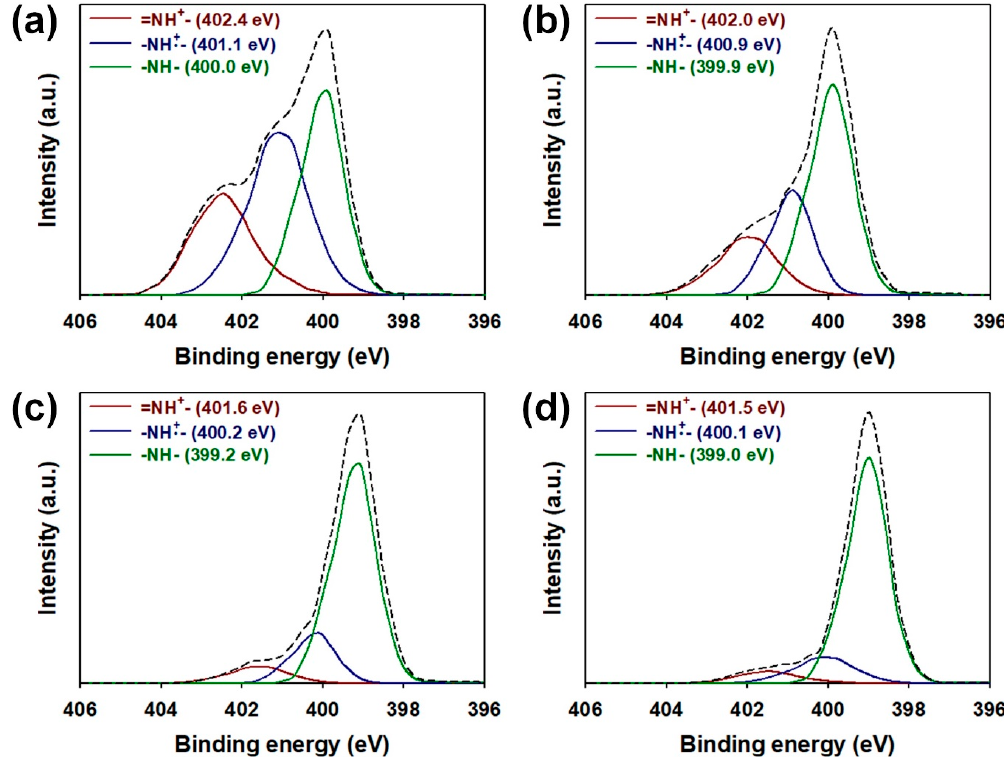
Figure 4. XPS core spectra in the N(1s) region of ( a ) ex situ 12 nm; ( b ) ex situ 22 nm; ( c ) in situ 12 nm, and ( d ) in situ 22 nm.